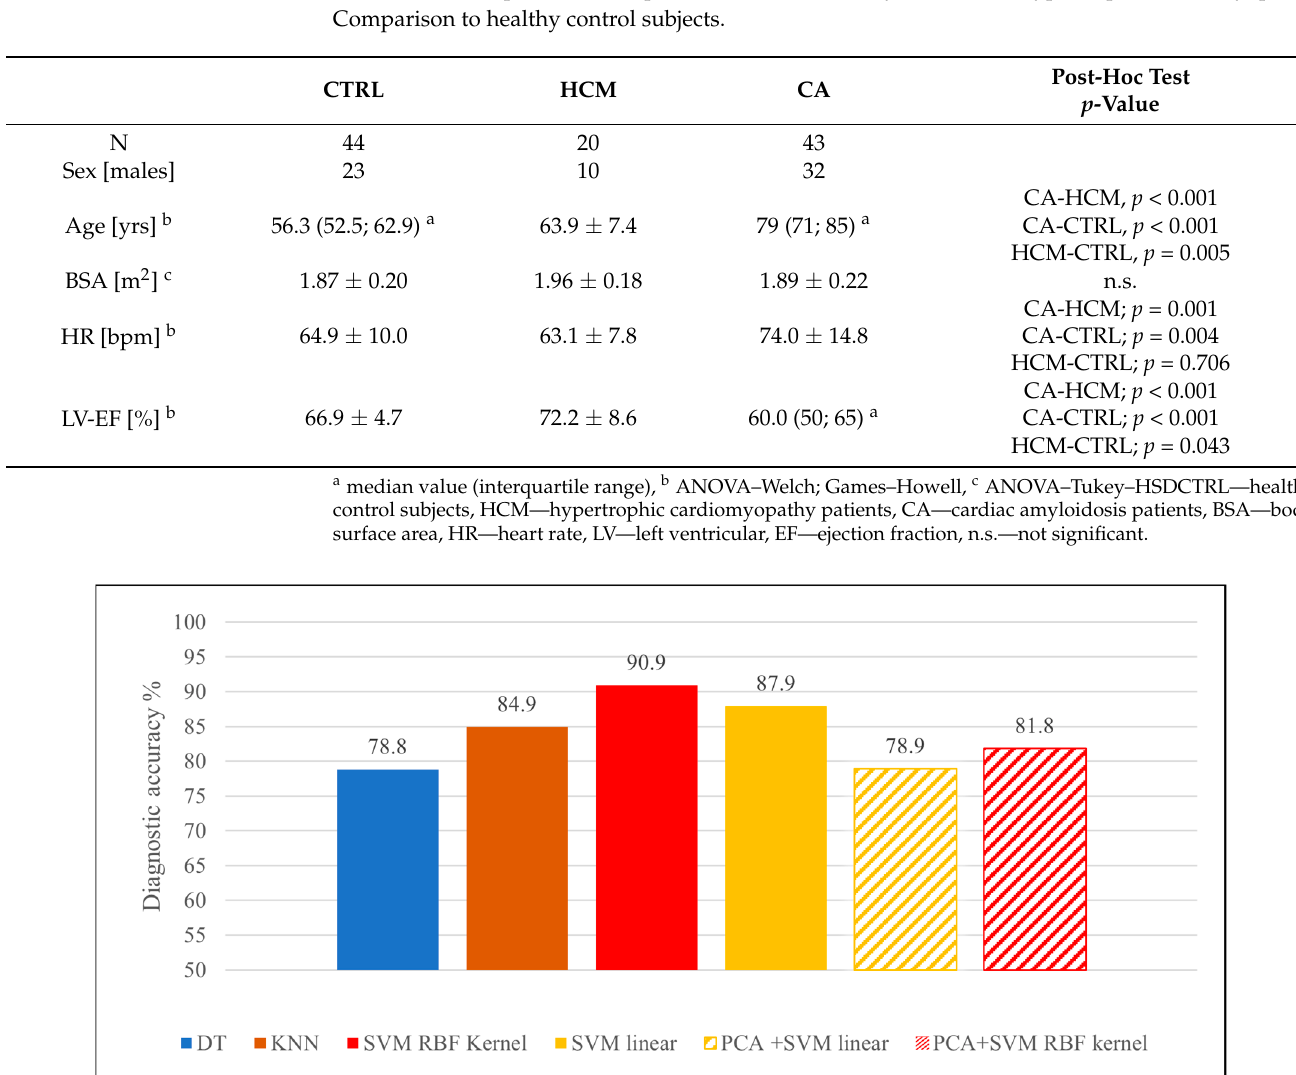
Figure 3. Diagnostic accuracies achieved by the various classifier